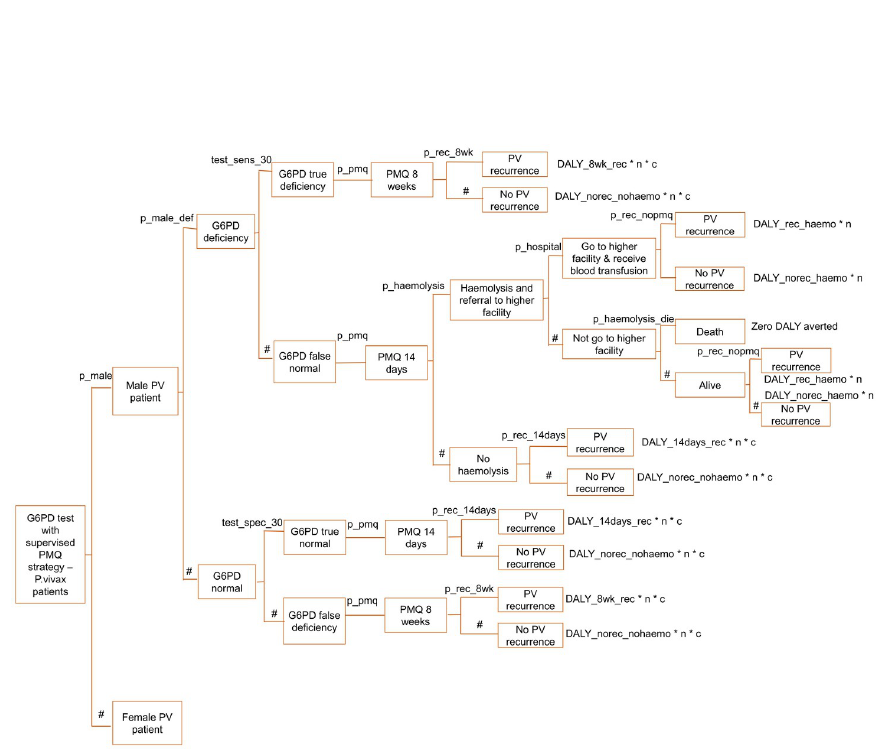
Fig 5. Decision tree model for G6PD test with supervised PMQ strategy—Male arm.